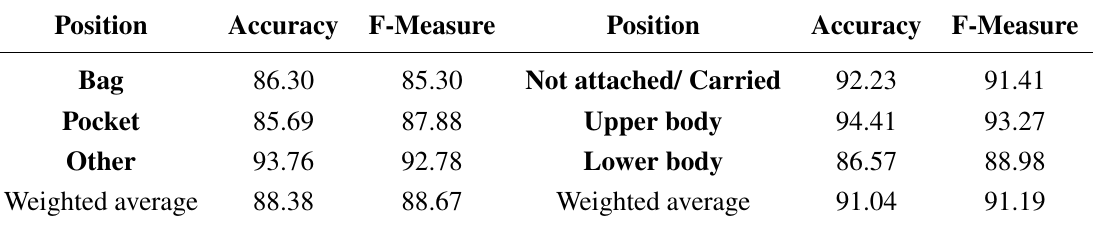
Table 11. Results of the 3-class